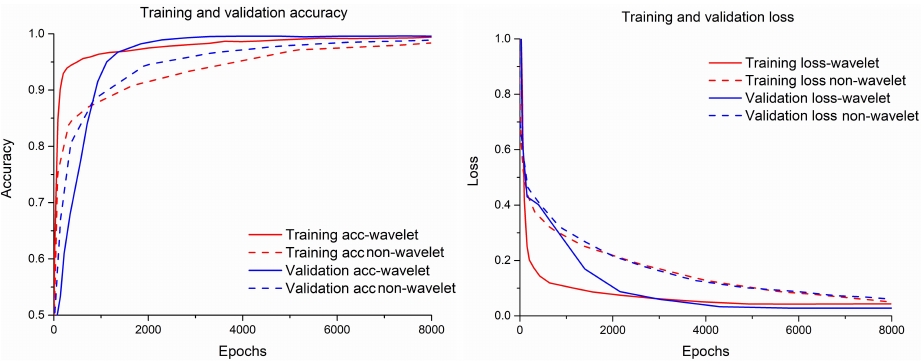
Figure 15. The accuracy curve and loss curve of the wavelet model and non-wavelet model. As for the accuracy of detection, the results and comparisons are shown in Table 3.